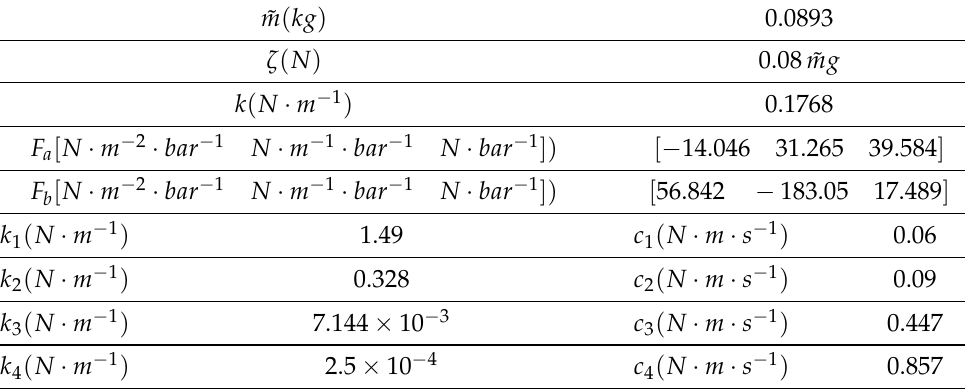
Figure 6. The results of the system identification and validation: ( a ) the identification result while applying two sweep signals; ( b , c ) are validation results while applying square signal and triangle signal, respectively. Table 1. The identified model